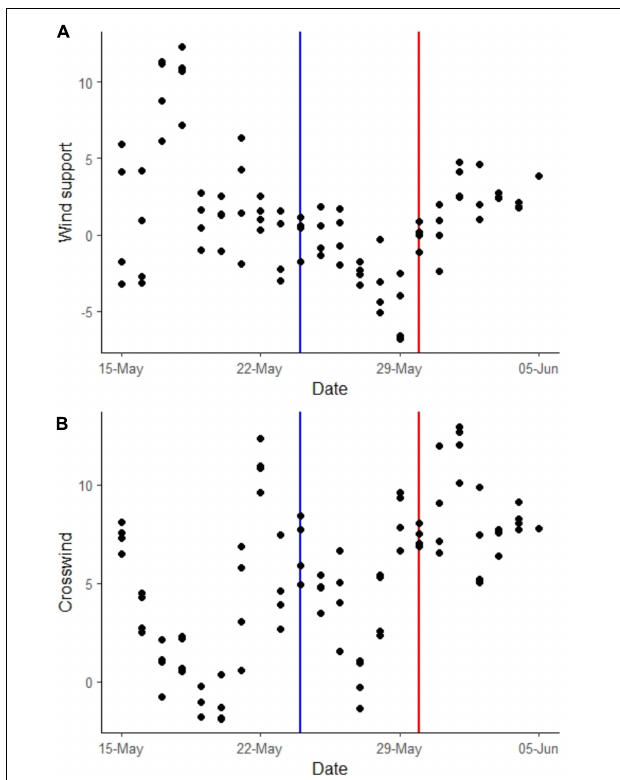
FIGURE 5 | Wind conditions experienced by light-bellied brent geese (LBBG) staging on the Álftanes peninsula between 15/05/17 and 05/06/17. The blue line is the date when LBBG weight gain attenuates (24/05/17) and the red line is the date of their mass departure (30/05/17). Wind conditions were calculated as either (A) wind support, with positive values indicating a tailwind and negative values a head wind and (B) crosswind was taken as an absolute value irrespective of direction. Calculated with a reference heading direction on the southeast coast of Greenland (65 ◦ 42 (cid:48) N, 37 ◦ 42 (cid:48)